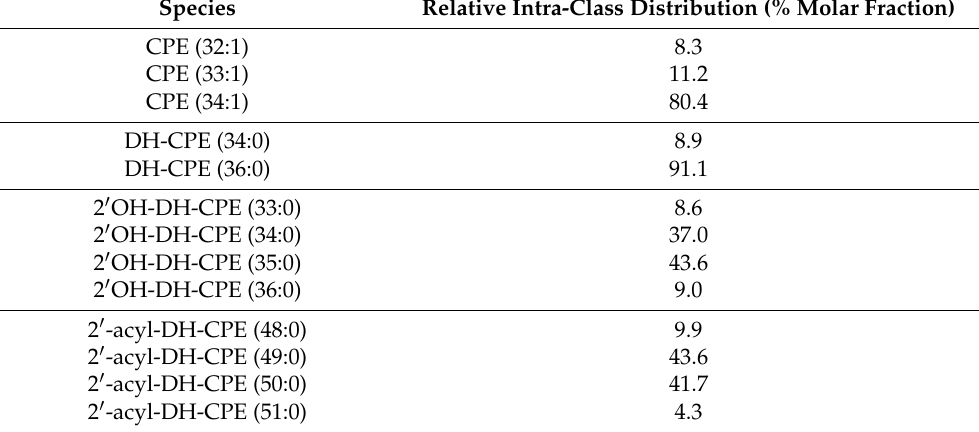
Table 2. Intra-class relative distribution of lipid species in the four ceramide classes from Tannerella forsythia (% molar